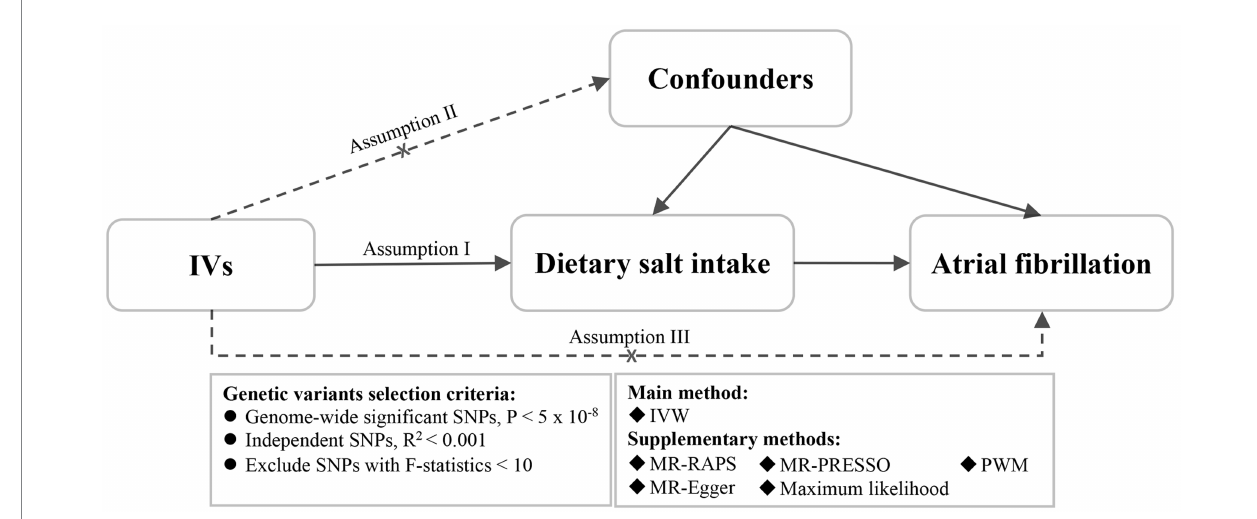
FIGURE 1 Assumptions of the Mendelian randomization analysis for dietary salt intake and the risk of atrial fibrillation. IVs, instrumental variables; SNPs: single nucleotide polymorphisms; IVW, inverse variance weighted; MR-RAPS, Mendelian randomization robust adjusted profile score; MR-PRESSO: Mendelian randomization pleiotropy residual sum and outlier; PWM, penalized weighted median; MR-Egger, Mendelian randomization-Egger.